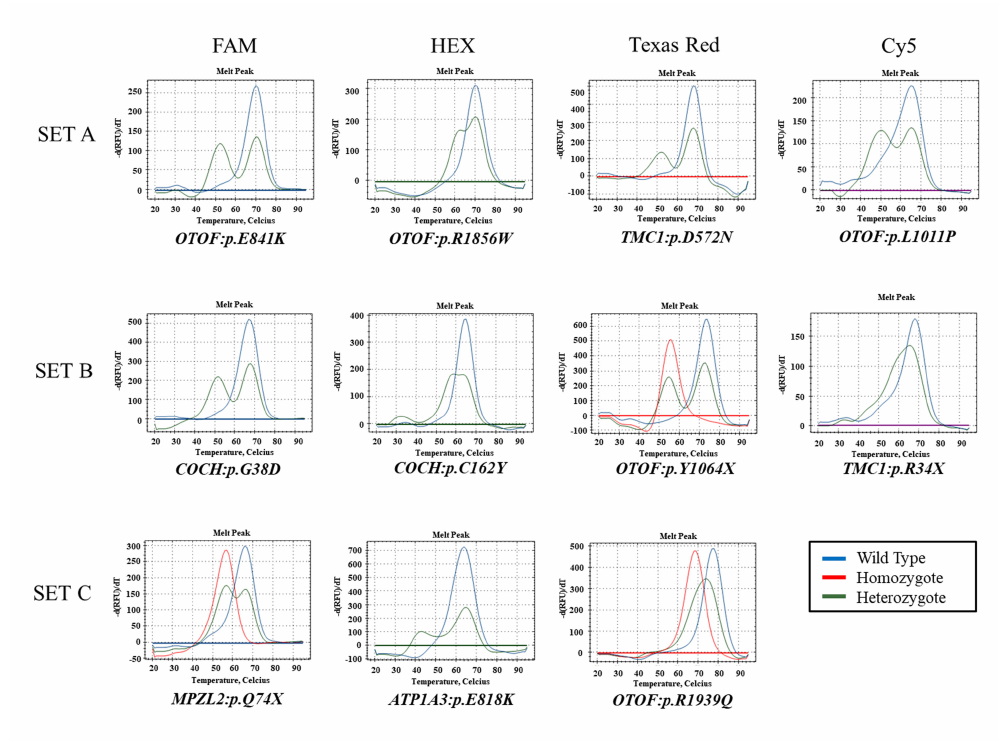
Figure 1. Melting peaks of 11 variants from five deafness genes comprising two ANSD genes ( OTOF and ATP1A3 )andthreeSNHLgenes( MPZL2 , COCH ,and TMC1 )withadistinctauditoryphenotype among Koreans. The blue, green, and red lines indicate wild type, heterozygous, and homozygous mutants, respectively. Each hearing loss set contains 3 or 4 peptide nucleic acid (PNA) probes labeled with FAM, HEX, Texas Red, and Cy5